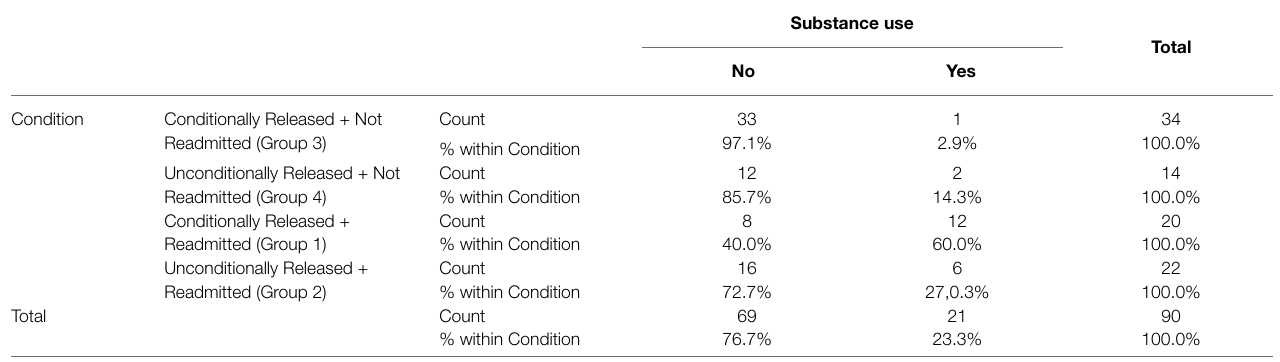
TABLE 2 | Crosstab – condition (readmission, conditional release) and substance use.